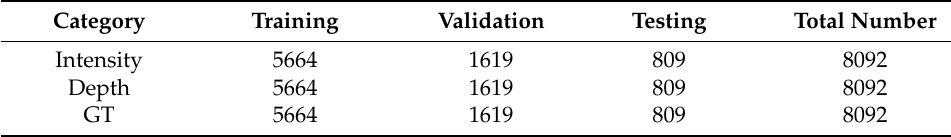
Table 1. The images distribution of the RTSD